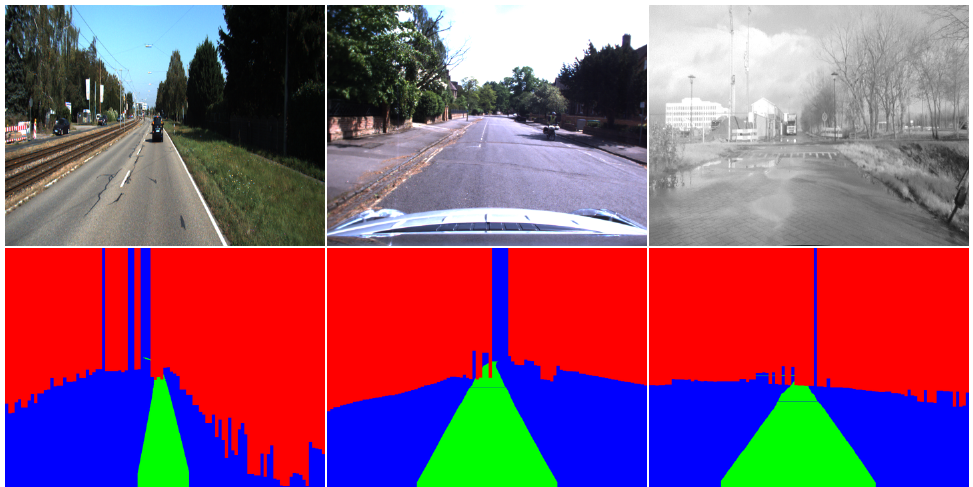
Figure 3: Example images and created labels of the KITTI raw dataset (left), Oxford RobotCar (middle) and the WEpod dataset (right). Red refers to occupancies, blue to unknown area and the drivable path is depicted as green. on the CityScapes dataset and will be fine-tuned in two